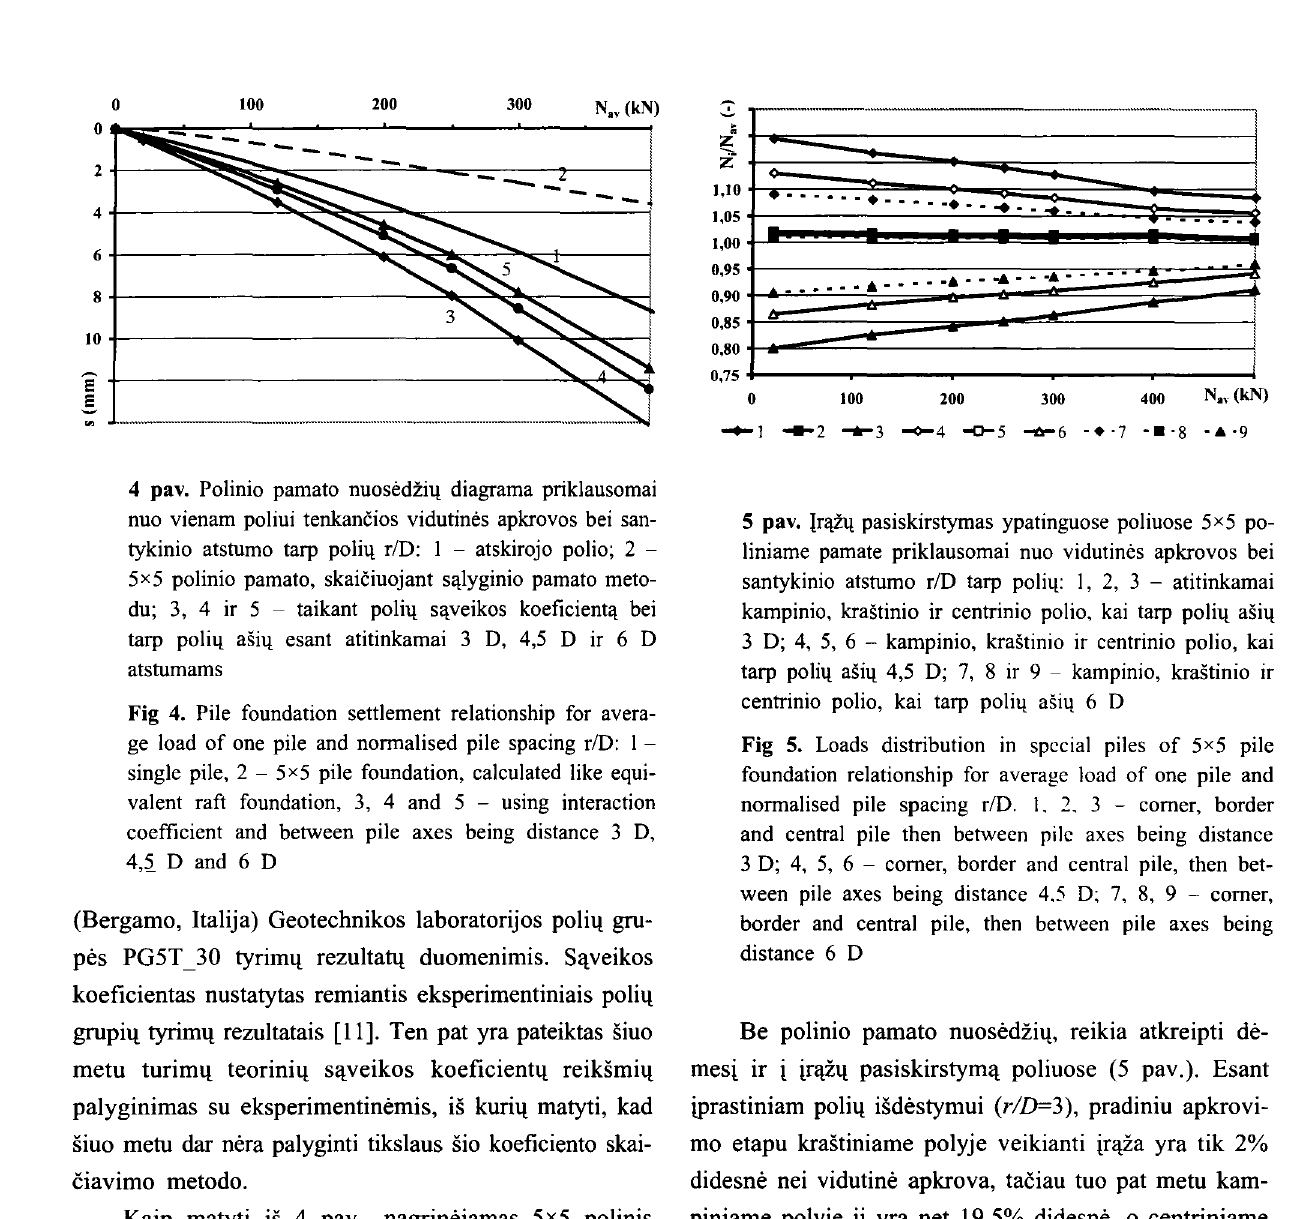
tykinio atstumo tarp polil! r/D: I - atskirojo polio; 2 - 5x5 polinio pamato, skaiciuojant S!!lyginio pamato meto